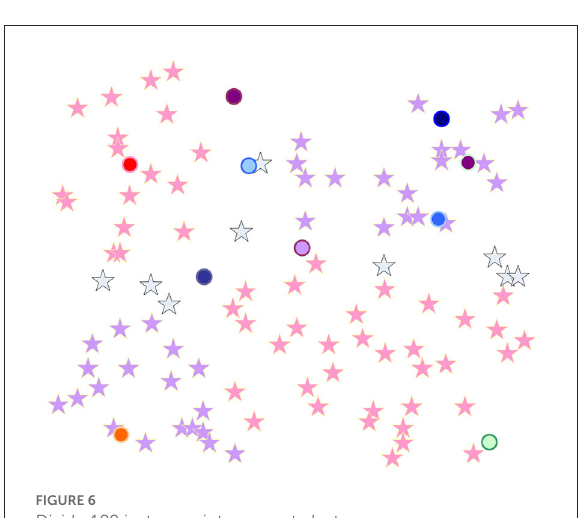
FIGURE6 Divide 100 instances into nearest clusters.